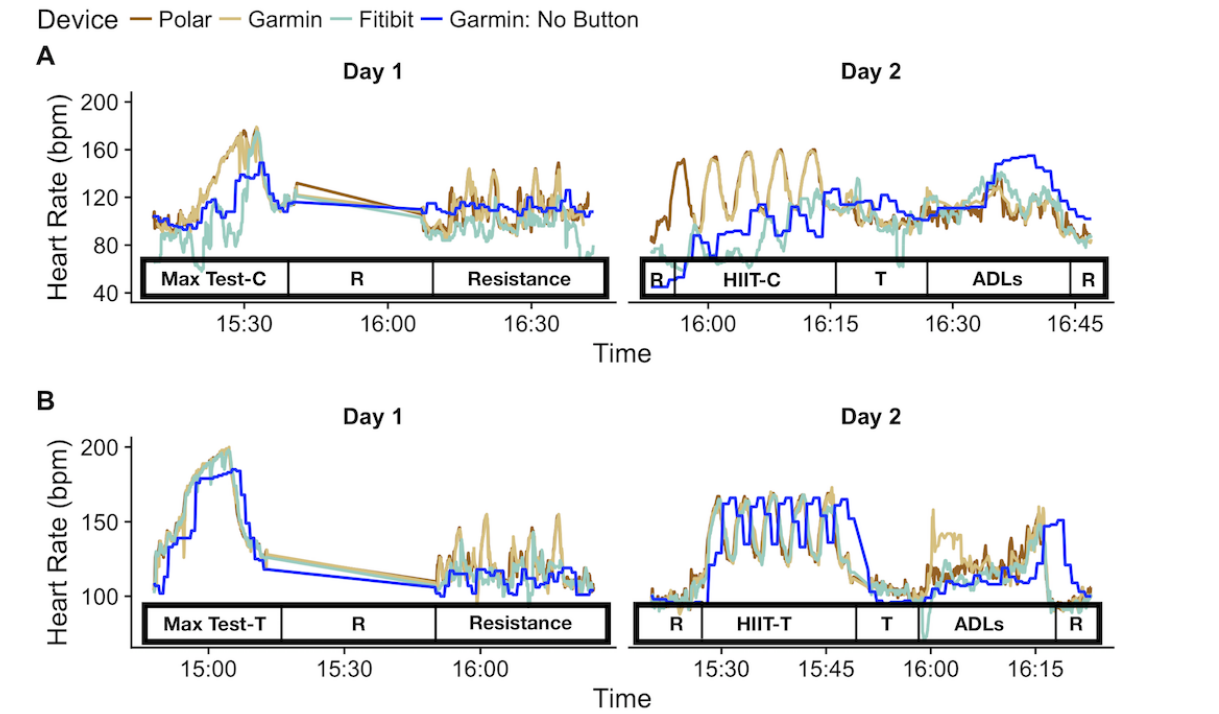
Figure 1. Two-day study protocol with “R” indicating the rest periods and “T” indicating the transition period between the different types of activities. Data are shown from 2 different participants wearing all devices in panels A and B. Note, Garmin devices were worn by the participants here in 2 different modes: one with the activity mode indicated (Garmin) and the other without (Garmin: No Button). Panel A shows the data during the cycle ergometer tests and panel B shows the data from the treadmill tests. Data in panel A highlight the error observed during higher intensity exercises where wrist movement was less pronounced during cycle ergometer testing. Panel B shows treadmill results when the Garmin, Fitbit, and Polar data are very closely matched across the exercise types. ADLs: activities of daily living; C: cycle ergometer; HIIT-C: high-intensity interval training-Cycle ergometer; HIIT-T: high-intensity interval training-Treadmill; T: